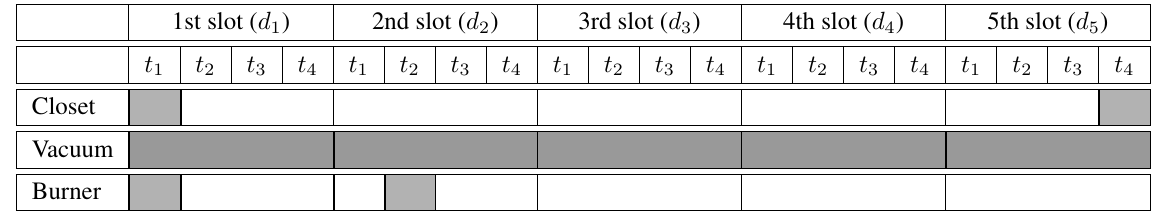
Table 2. The IAGC representation of participant’s input for